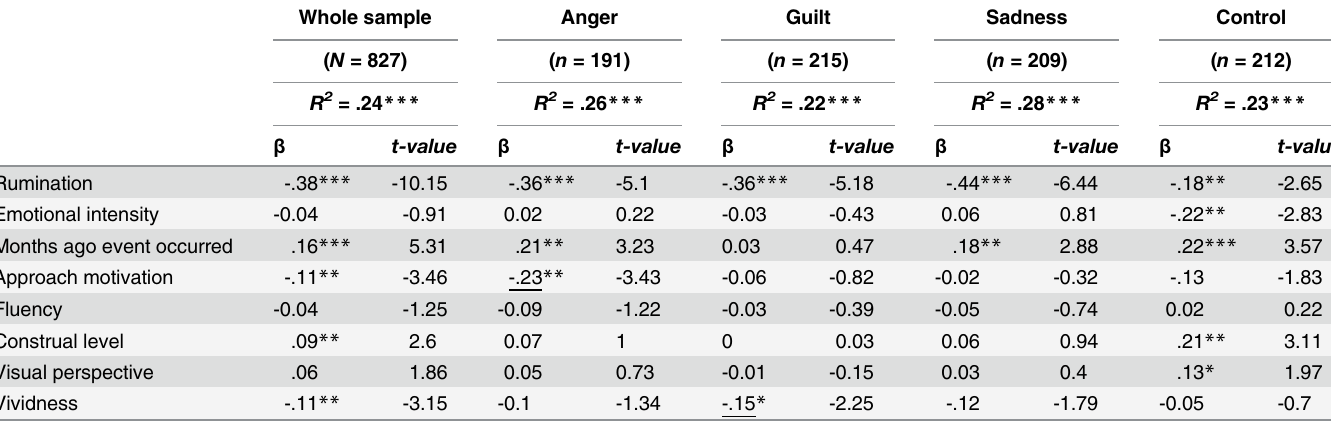
The left column represents the whole sample controlling for condition. Regression coef fi cients are standardized. Underlined coef fi cients indicate signi fi cant